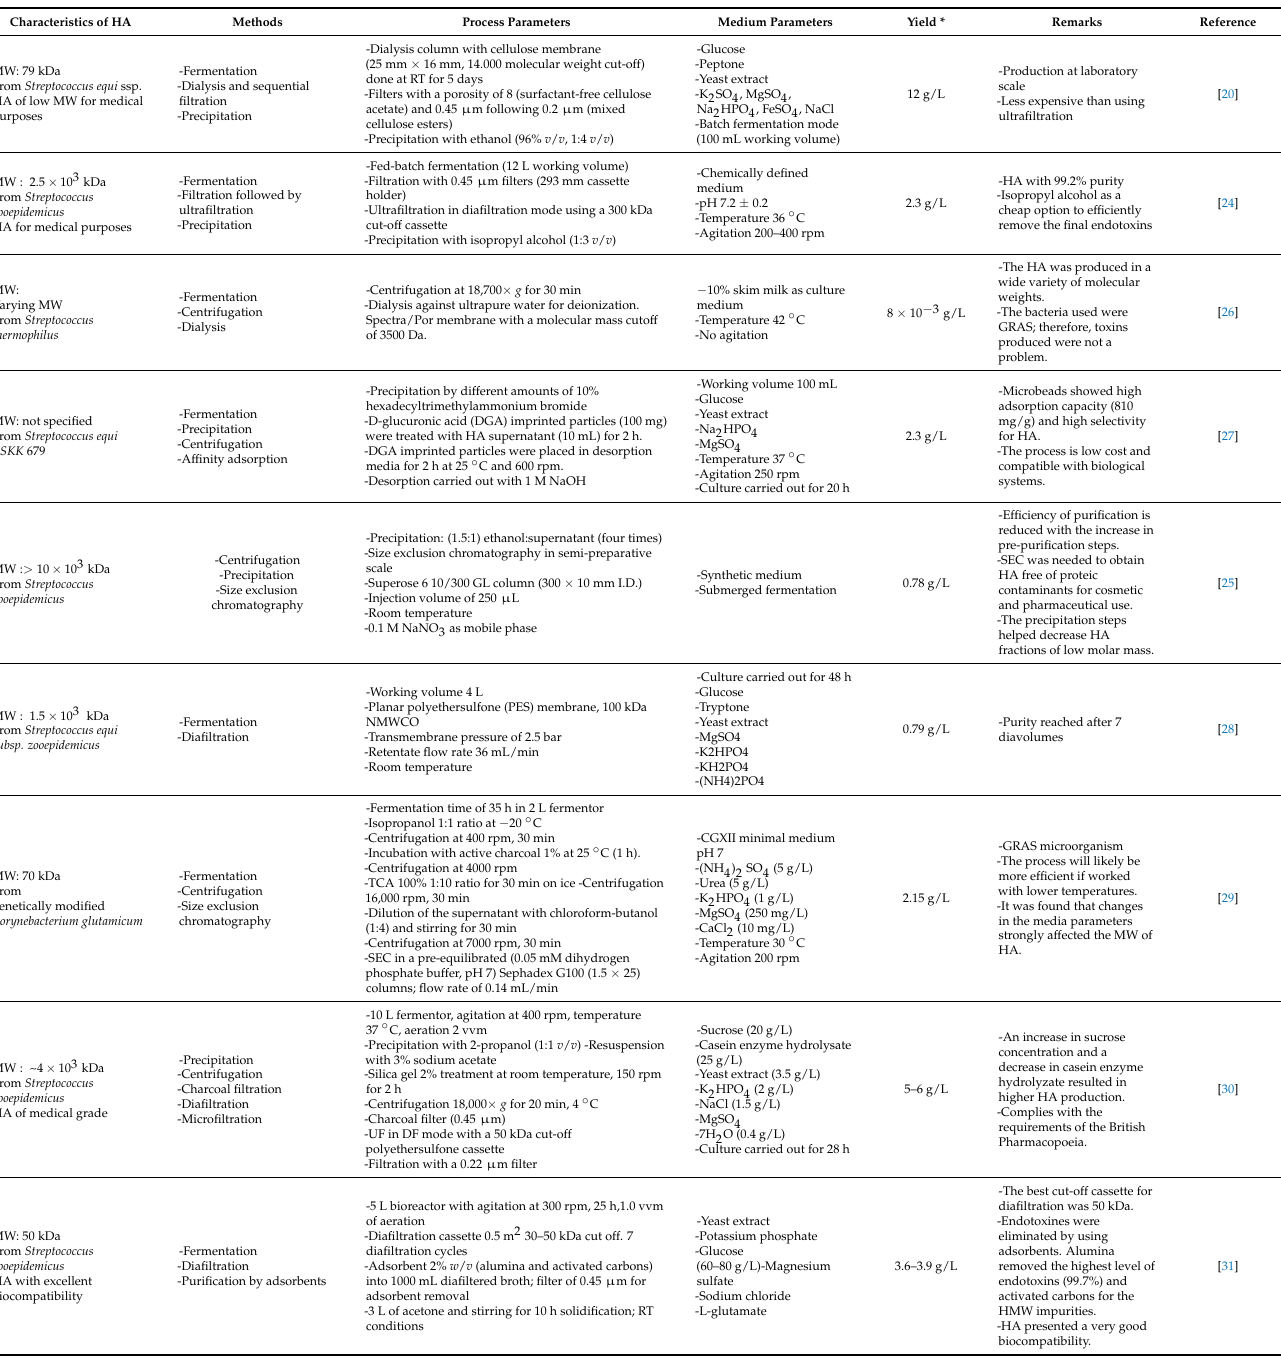
Table 3. Advances in extraction and production of HA using different bacterial